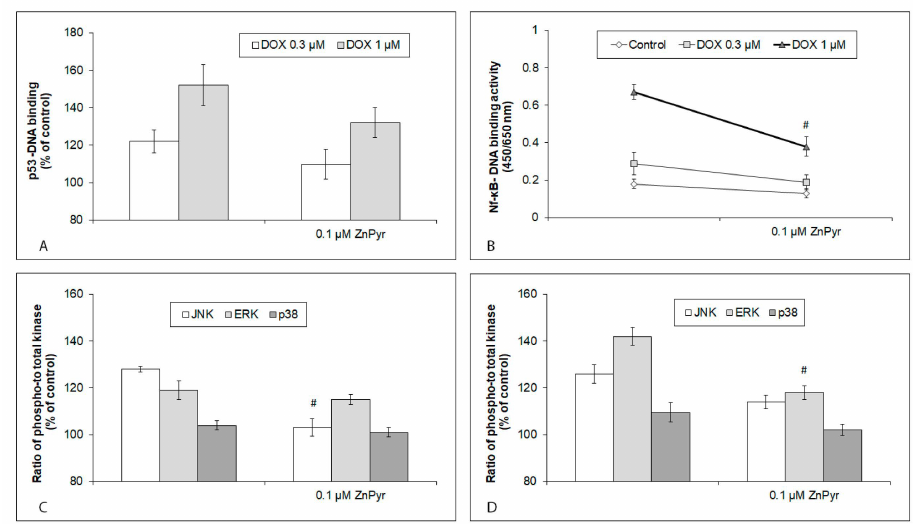
Figure 8. Effects of enhanced intracellular free Zn levels on intracellular signaling in hiPCS-CMs exposed to 0.3 µ M and 1 µ M DOX at 120 h. Cardiomyocytes were treated with 0.1 µ M zinc pyrthione (ZnPyr) alone or together with 0.3 µ M and 1 µ M DOX concentrations, and ( A ) p53 activity, ( B ) NF- κ B activity, ( C ) MAP kinases activity upon treatment with 0.3 µ M DOX, and ( D ) MAP kinases activity upon treatment with 1 µ M DOX were determined by particular assays and procedures, as described in Section 4. Values represent means ± SD of N = 3 (p53 activity), N = 3 (NF- κ B activity), N = 3 (MAP kinases activity at 0.3 µ M DOX), and N = 3 (MAP kinases activity at 1 µ M DOX) experiments. # p < 0.05 compared to DOX treated cells at the same treatment interval with one-way ANOVA test and Dunnett’s post test for multiple